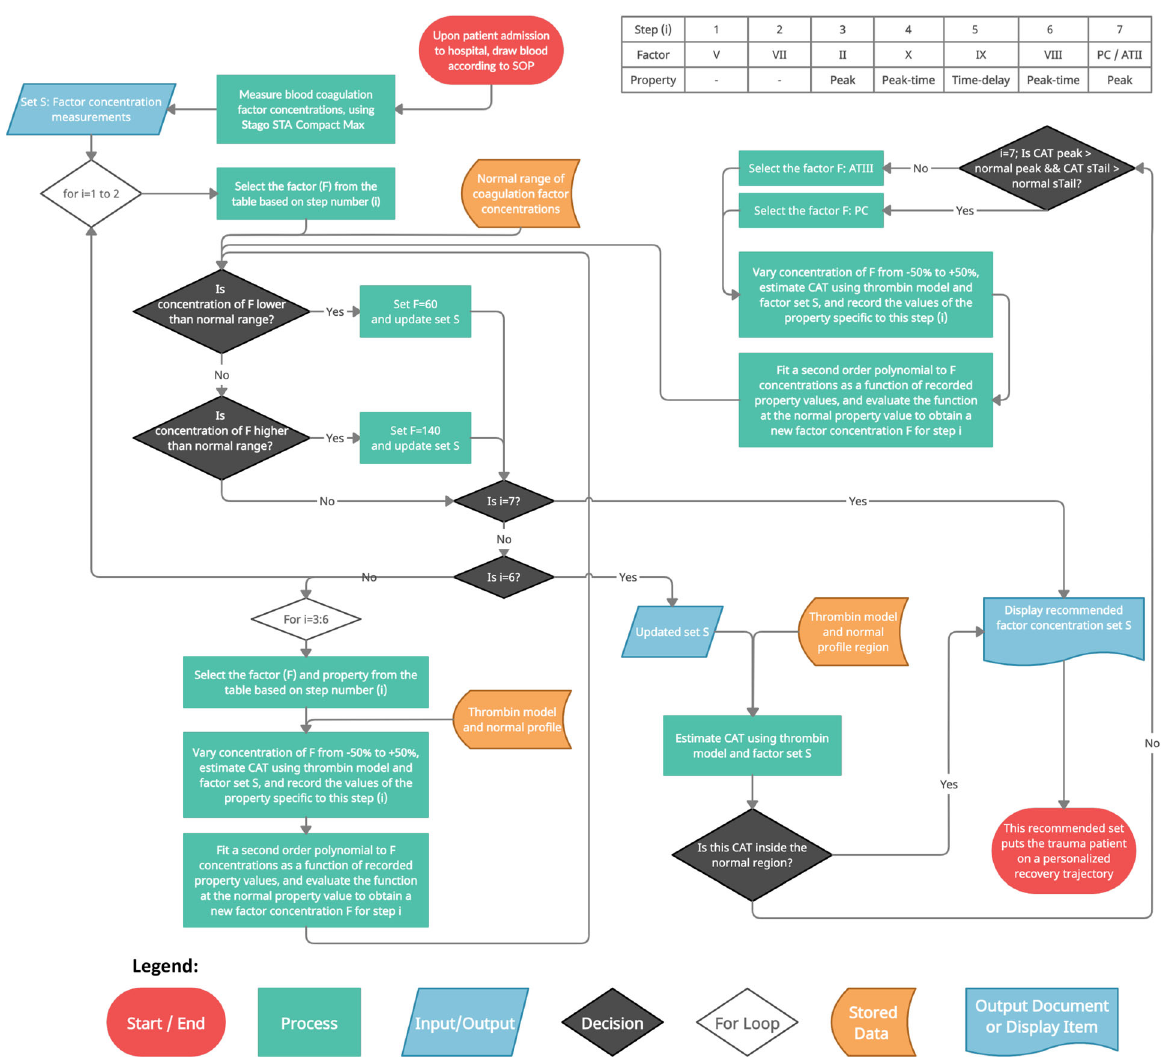
Fig. 8 Flowchart of the proposed GCM algorithm that enables frequent, dynamic, and personalized TIC treatment. This algorithm systematically recommends coagulation factor concentrations to move a patient CAT trajectory toward normal, while also maintaining concentration values within normal activity ranges. This algorithm serves as the controller block in Fig.